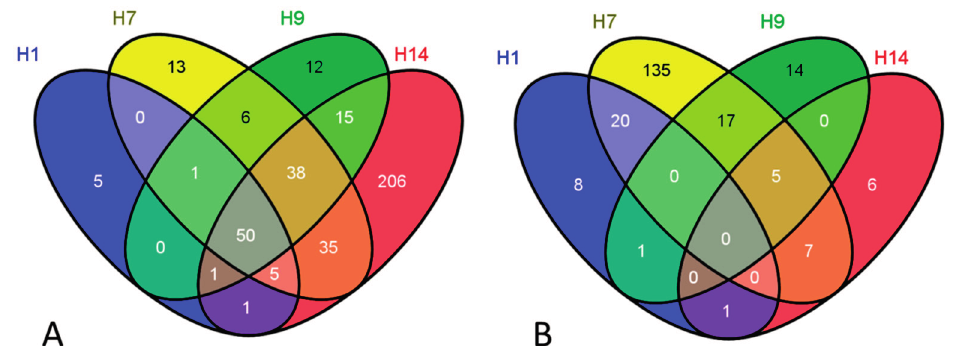
Figure 2. Venn diagrams of differentially expressed genes following high-dose ionizing radiation (HDIR) exposures (2 h): ( A ) induced genes and ( B ) repressed